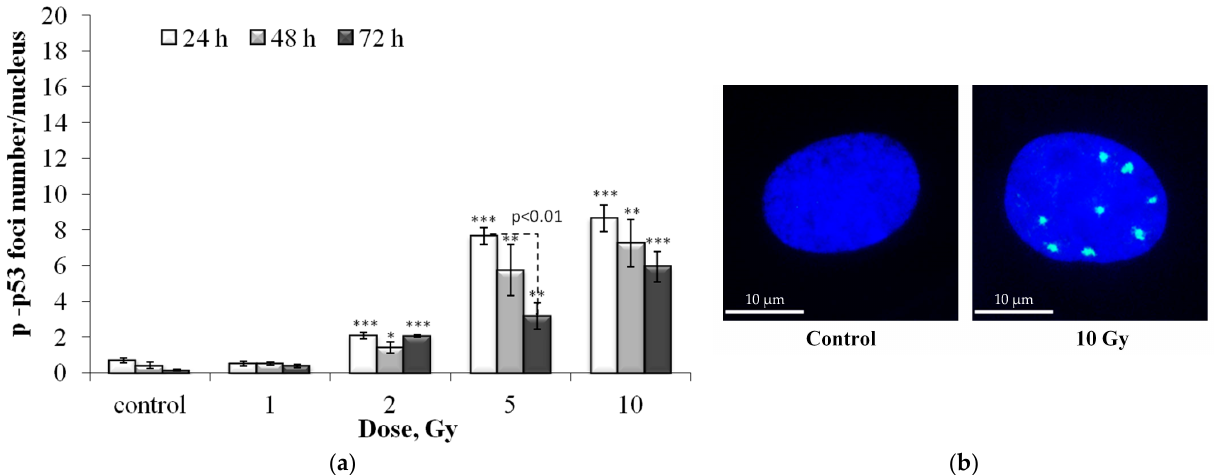
Figure 4. ( a ) Dose-dependent changes in the number of residual p-p53 foci in human fibroblasts 24 h, 48 h and 72 h after irradiation. Data are means ± SE of three independent experiments. * p < 0.05, ** p < 0.01 and *** p < 0.001—compared with the corresponding time of control; ( b ) Representative microphotographs of immunocytochemically stained control and 10 Gy irradiated cells (24 h) showing nucleus (blue) and foci (green).